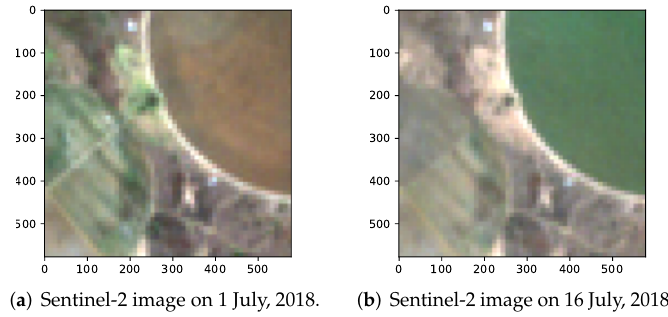
Figure 18. Sentinel-2 images of a false-positive blob of crops in Pretoria Rural.